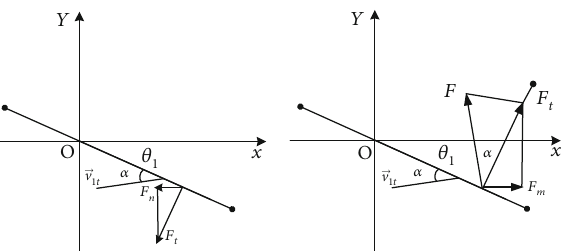
Figure 16: Schematic diagram of the caudal fi n ’ s fl uid pressure decomposition and lift force